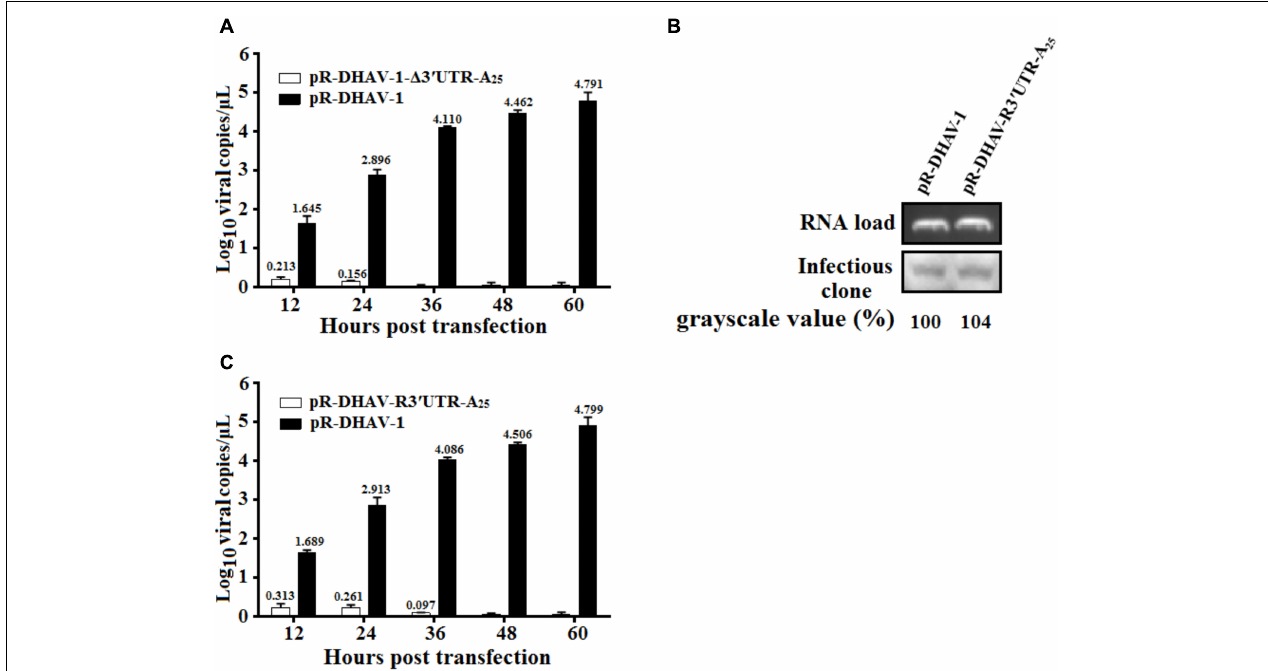
FIGURE 4 | The 3 (cid:48) UTR is essential for viral genome replication. (A) 0.8 µ g of the in vitro transcribed products of pR-DHAV-1 or pR-DHAV- (cid:49) 3 (cid:48) UTR-A 25 were transfected into DEFs, cell lysates were collected from 12 to 60 hpt and viral copy number was measured by RT-qPCR. (B) Equal amount of in vitro transcribed product of pR-DHAV-1 or pR-DHAV-R3 (cid:48) UTR-A 25 were transfected into DEFs, cell lysates were collected at 4 hpt to measure the remaining amount of viral RNAs. (C) Equal amount of 0.8 µ g of the in vitro transcribed products of pR-DHAV-1 or pR-DHAV-R3 (cid:48) UTR-A 25 were transfected into DEFs to measure viral growth characteristics as previously described. Bars represent the means ± standard deviations of three replicate